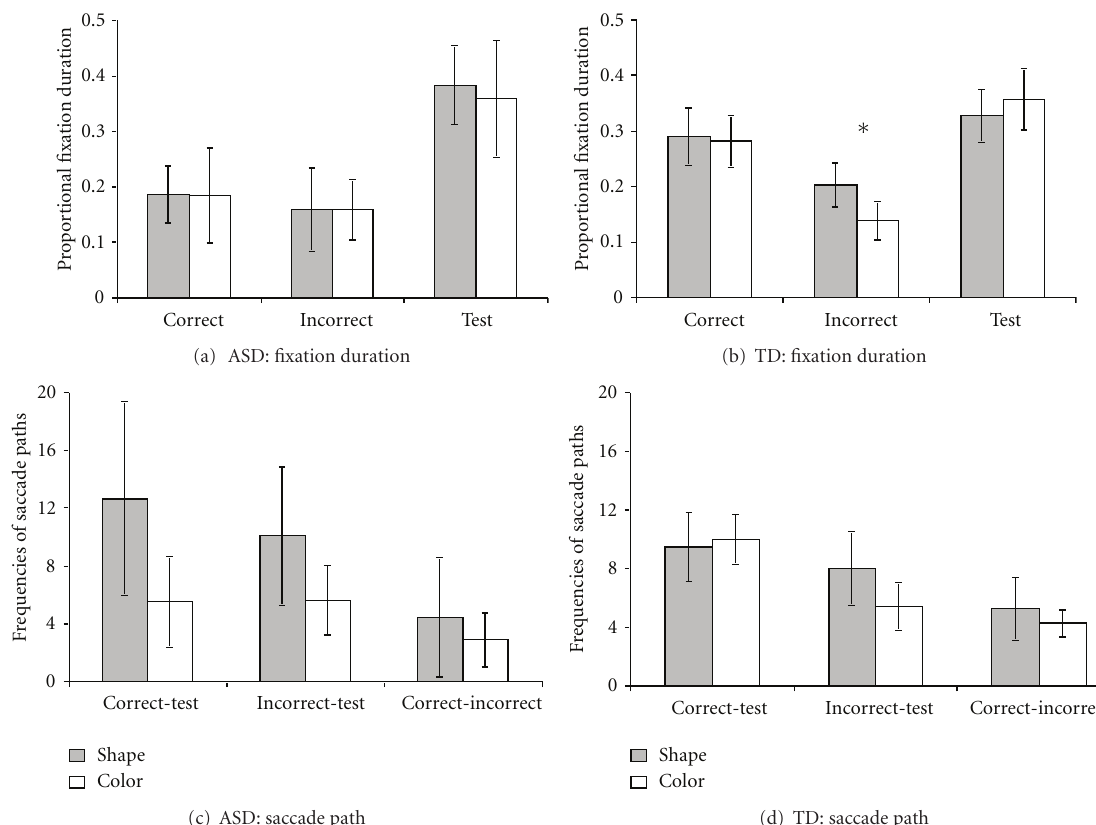
Figure 5: Proportional fixation durations within the correct, incorrect and the test cards for ASD (a) and TD children (b) following the shape rule (Order 1) or the color rule (Order 2) in the postswitch phase. (Error bars represent 95% confidence intervals). ∗ P < .